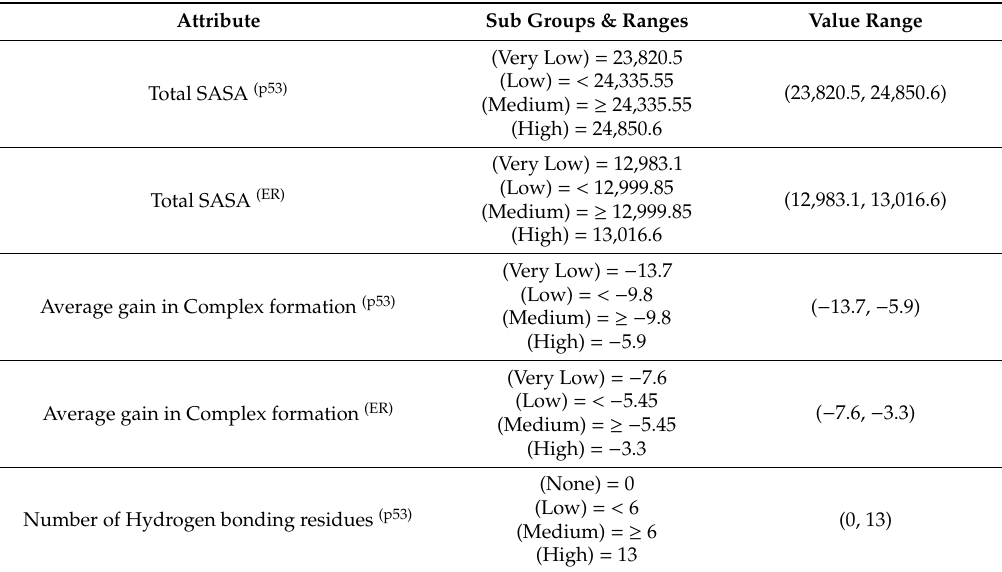
Table 3. Dataset pre-analysis used for building the neural network for p53–ER α